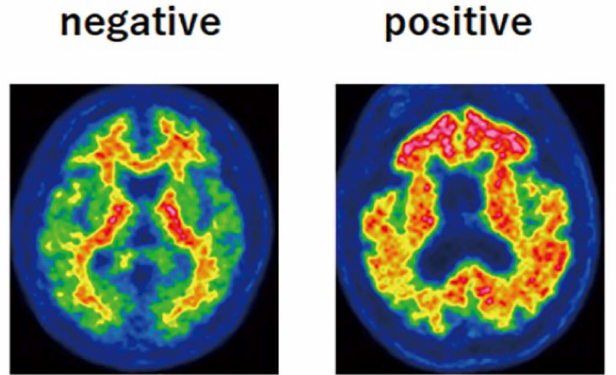
Figure 4. The evaluation was performed according to the criteria defined by the manufacturer, which involved visual assessment of five regions: frontal cortex, PC/PCC, lateral-parietal, lateral temporal, and striatum. The final classification was either positive (unilateral binding in one or more cortical brain regions or striatum; ( right )) or negative (predominantly white matter uptake; ( left )).